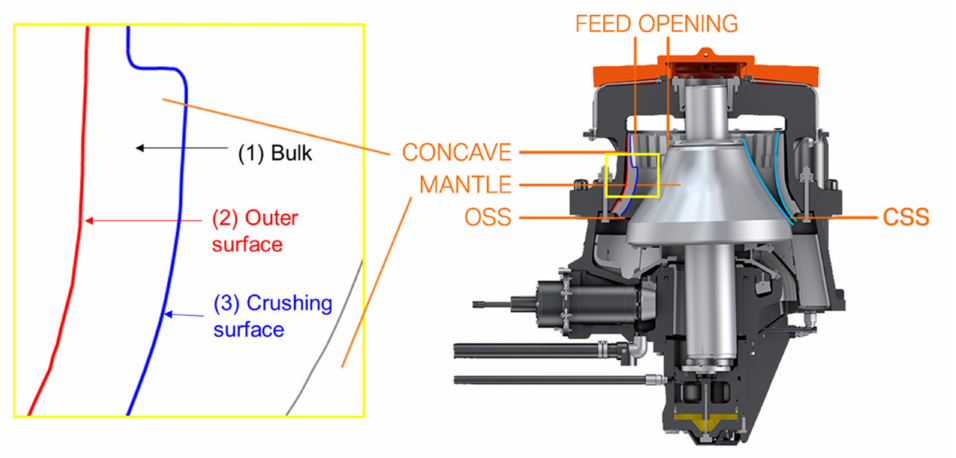
Figure 2. Diagram of a cone crusher showing a concave